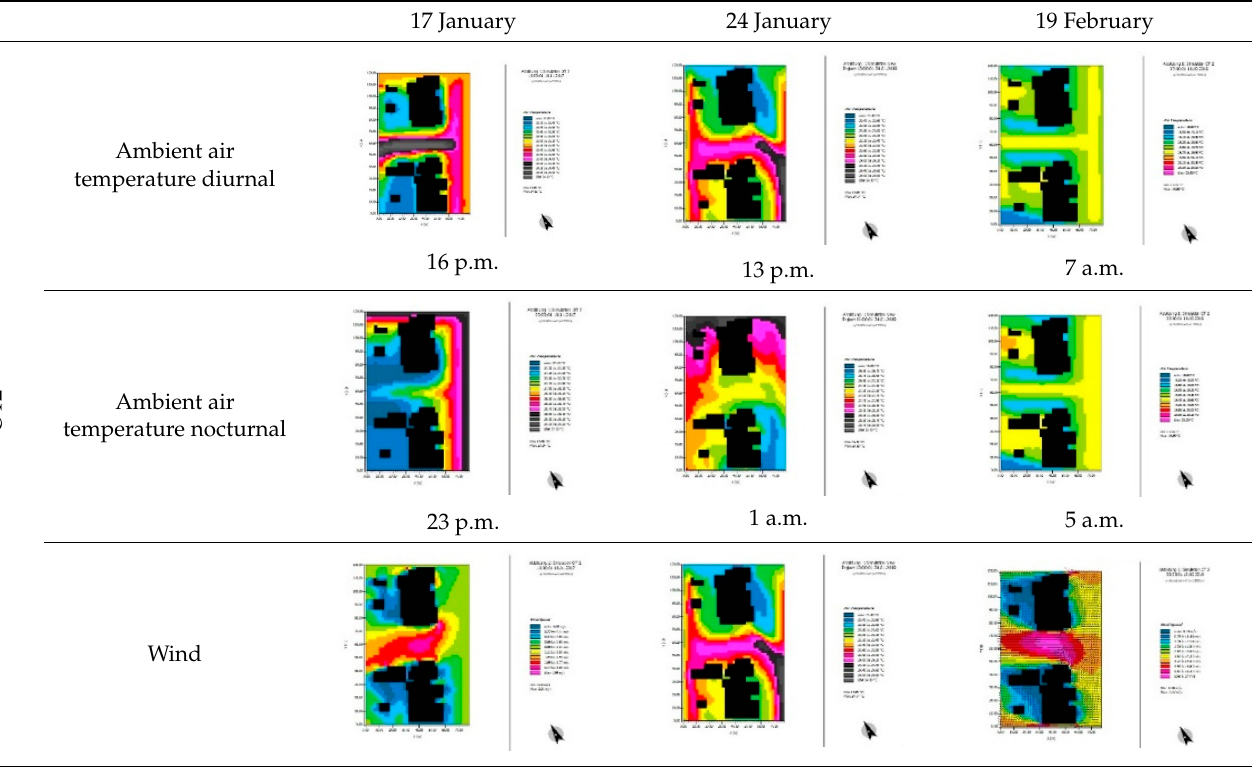
Table A4. Summary of heat island effect in open type series.